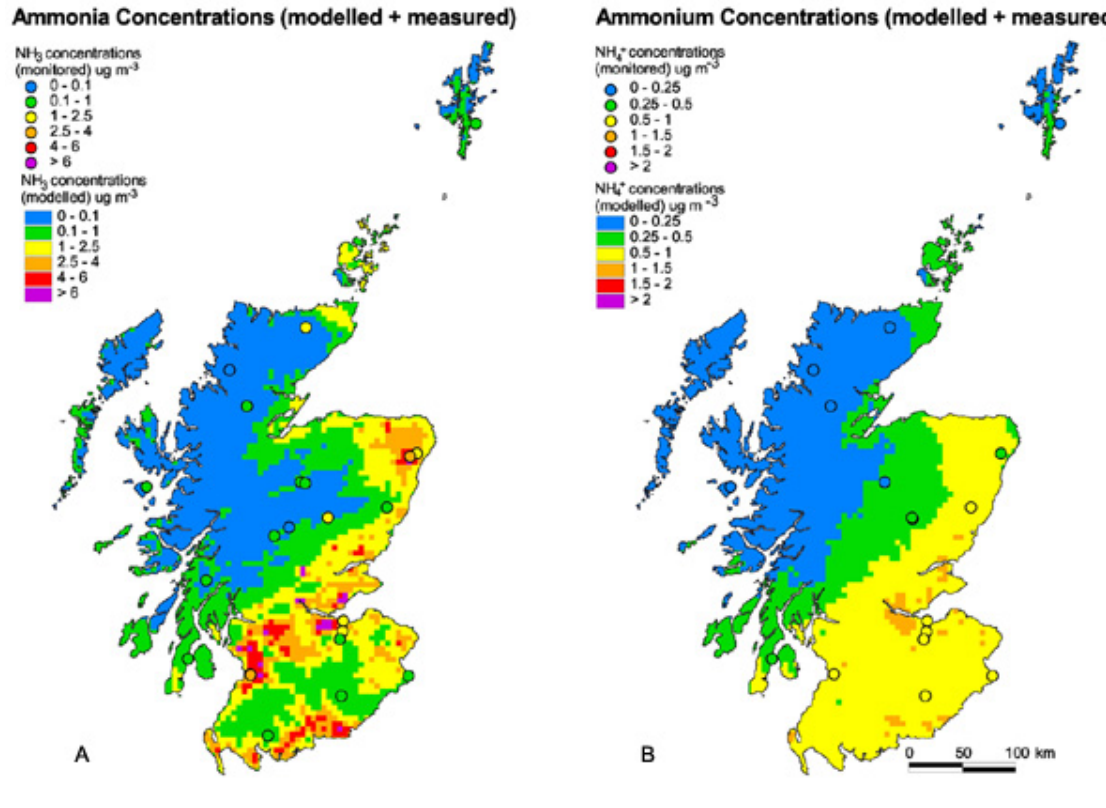
FIGURE 6. Spatial distribution of gaseous ammonia and aerosol ammonium across Scotland estimated by the FRAME model for 1996. The modelled values, shown on a 5-km grid, are compared with the mean measured concentrations (circles) from the National Ammonia Monitoring Network for the period